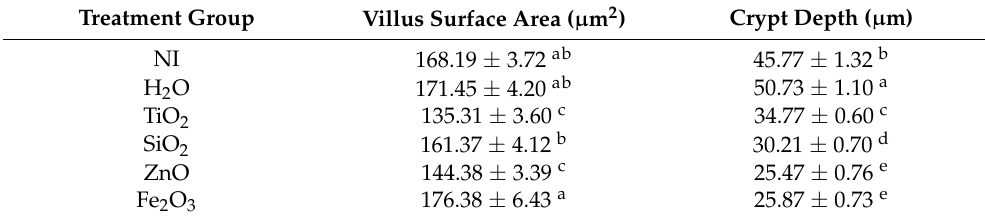
Table 5. Effects of intraamniotic administration of experimental food-grade NP solutions on duo- denal small intestinal villi and depth of crypts 1 .